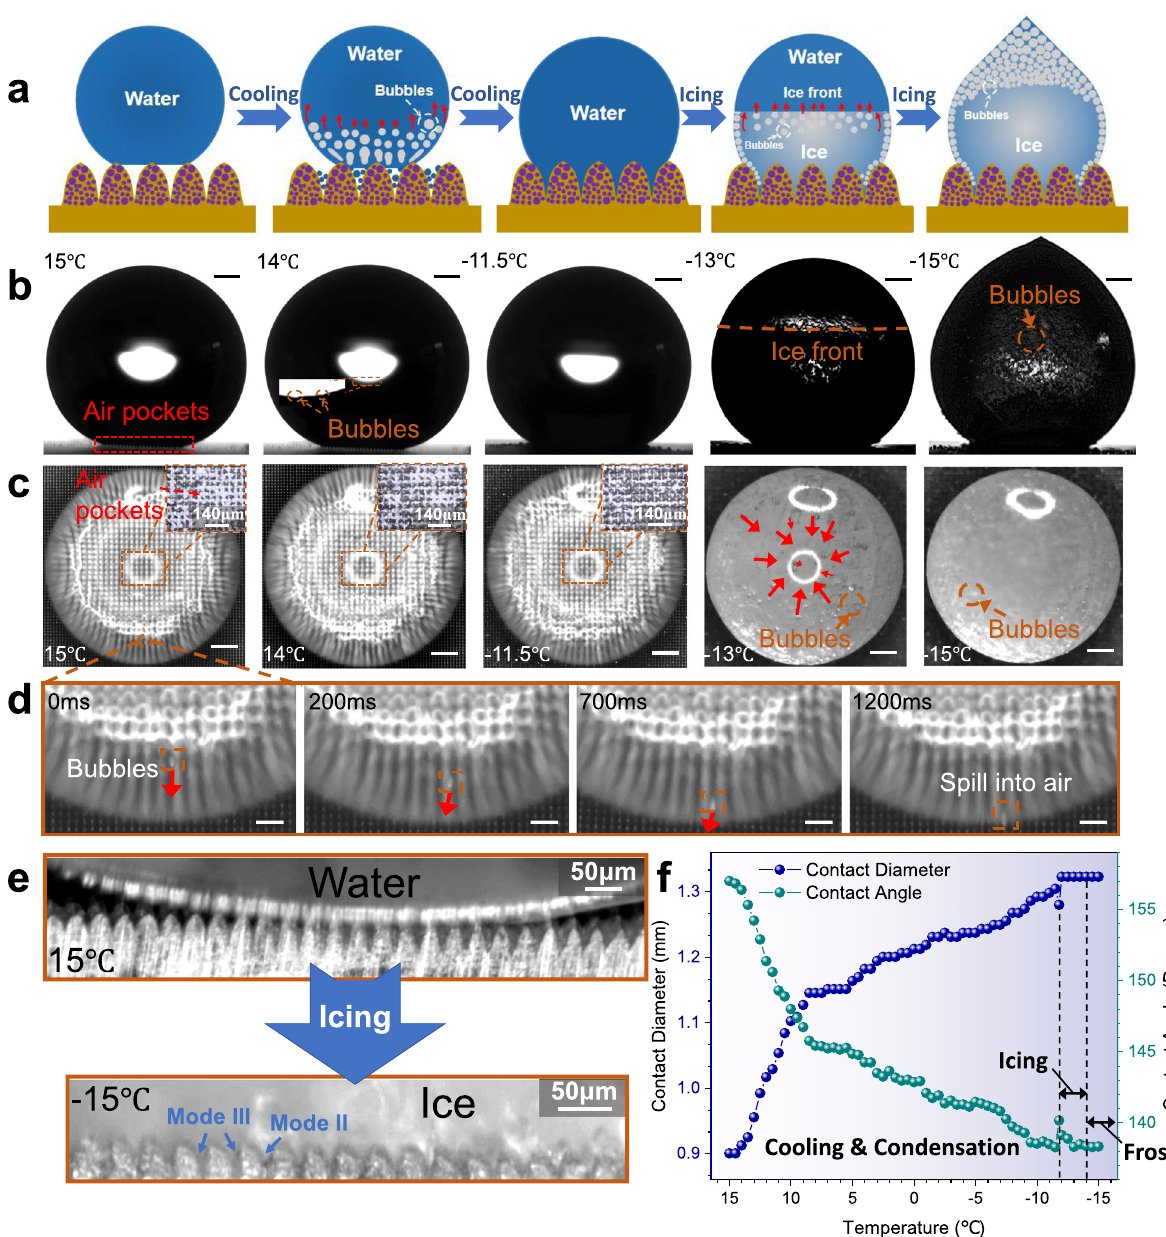
Fig. 4 Icing process of a droplet on the MCNP surface. a Schematic illustration of icing process. b Direct observation from the side view. Proof of bubbles forming in the icing process is shown via the magni fi ed picture. Orange dashed lines indicate the icing front. Bubbles and air pockets are marked with orange dashed boxes and red dashed boxes, respectively. c Direct observation from the top view. The magni fi ed observations from the top view for the disappearance of the underneath air pockets are shown in the 1st, 2nd, and 3rd pictures. The zones with lighter contrast in the magni fi ed pictures indicate air pockets, while those with darker contrast indicate the pinned zones. d Proof of bubbles movement. The bubble is marked with an orange dashed box. The moving directions of bubbles are marked with red arrows. e Observations for the original air pockets at 15 °C and ice penetration in the micro- nanostructure at − 15 °C. Ice permeation modes are marked with blue arrows. f The changes of contact diameters and angles of the droplet on the MCNP surface with the temperature decrease. Three stages of the icing process are marked by black dashed lines, which indicate the cooling and condensation stage, icing stage and frosting stage, respectively. Scale bars, times and temperatures corresponding to different states are marked. The scale bars of b – d are 300 μ m, 300 μ m, and 70 μ m, respectively. The fl uctuations of the correlation evaluations can be found in the Methods